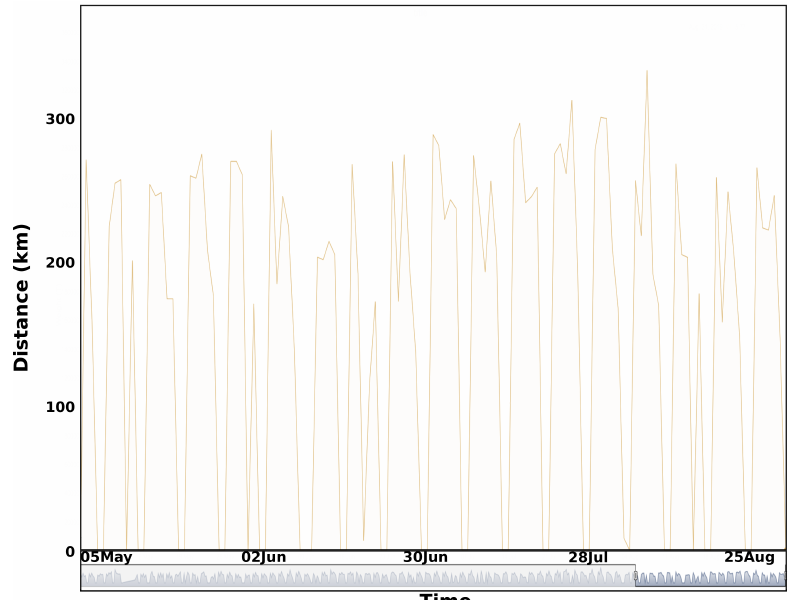
Figure 22. Traveled distance for the south waste collection tour between January–September 2019 (Average: 220 km, standard deviation: 54 km).